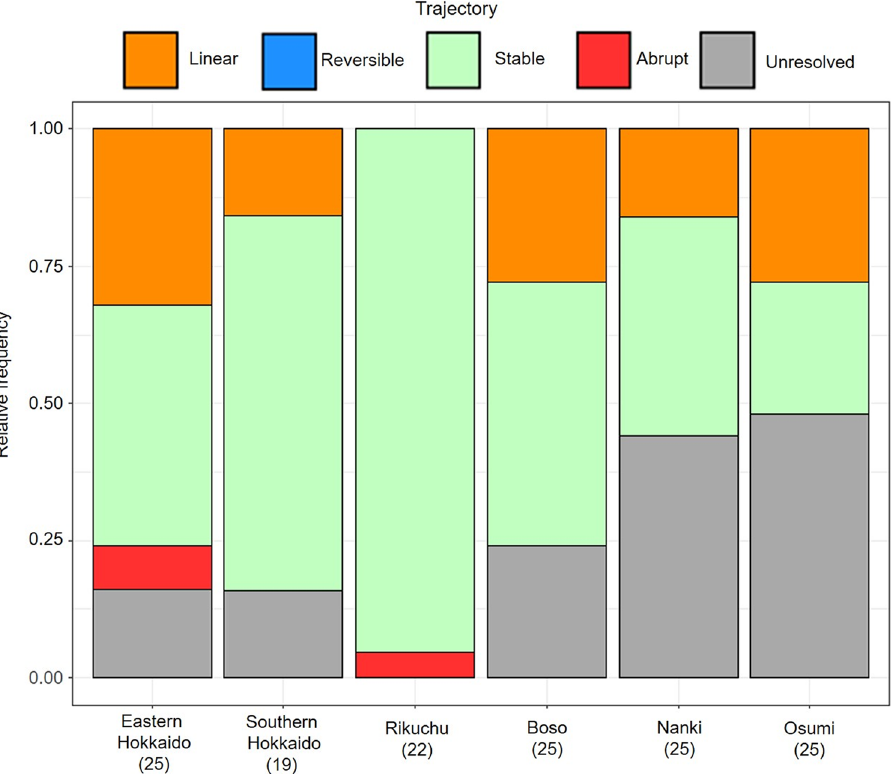
Figure 2. Relative frequencies of trajectories representing the patterns of ecological resilience of rocky intertidal sessile communities along the Pacific coast of Japan, based on the Sørensen dissimilarity index. Also shown are the relative frequencies of instances where trajectories could not be reliably classified (i.e., “unresolved”). The numbers of plots in each region are in parentheses.